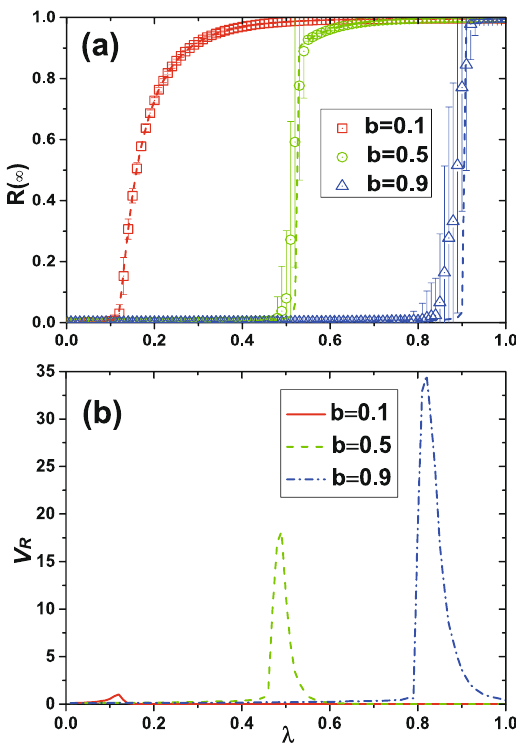
Figure 3. Illustration of effects of dynamical parameter b with arbitrary λ , where b is the LTI capacity parameter. ( a ) Under different b , the increase manner of final adoption size changes from continuity at small b (e.g. b = 0.1) to discontinuity at large b (e.g. b = 0.5), which embody the second-order and first-order phase transition. ( b ) v R numerically exhibits the fluctuation of R ( ∞ ) to intuitively emphasize the critical λ The higher peak, the more abrupt the discontinuity of R ( ∞ ) is (see b = 0.1, 0.5 and